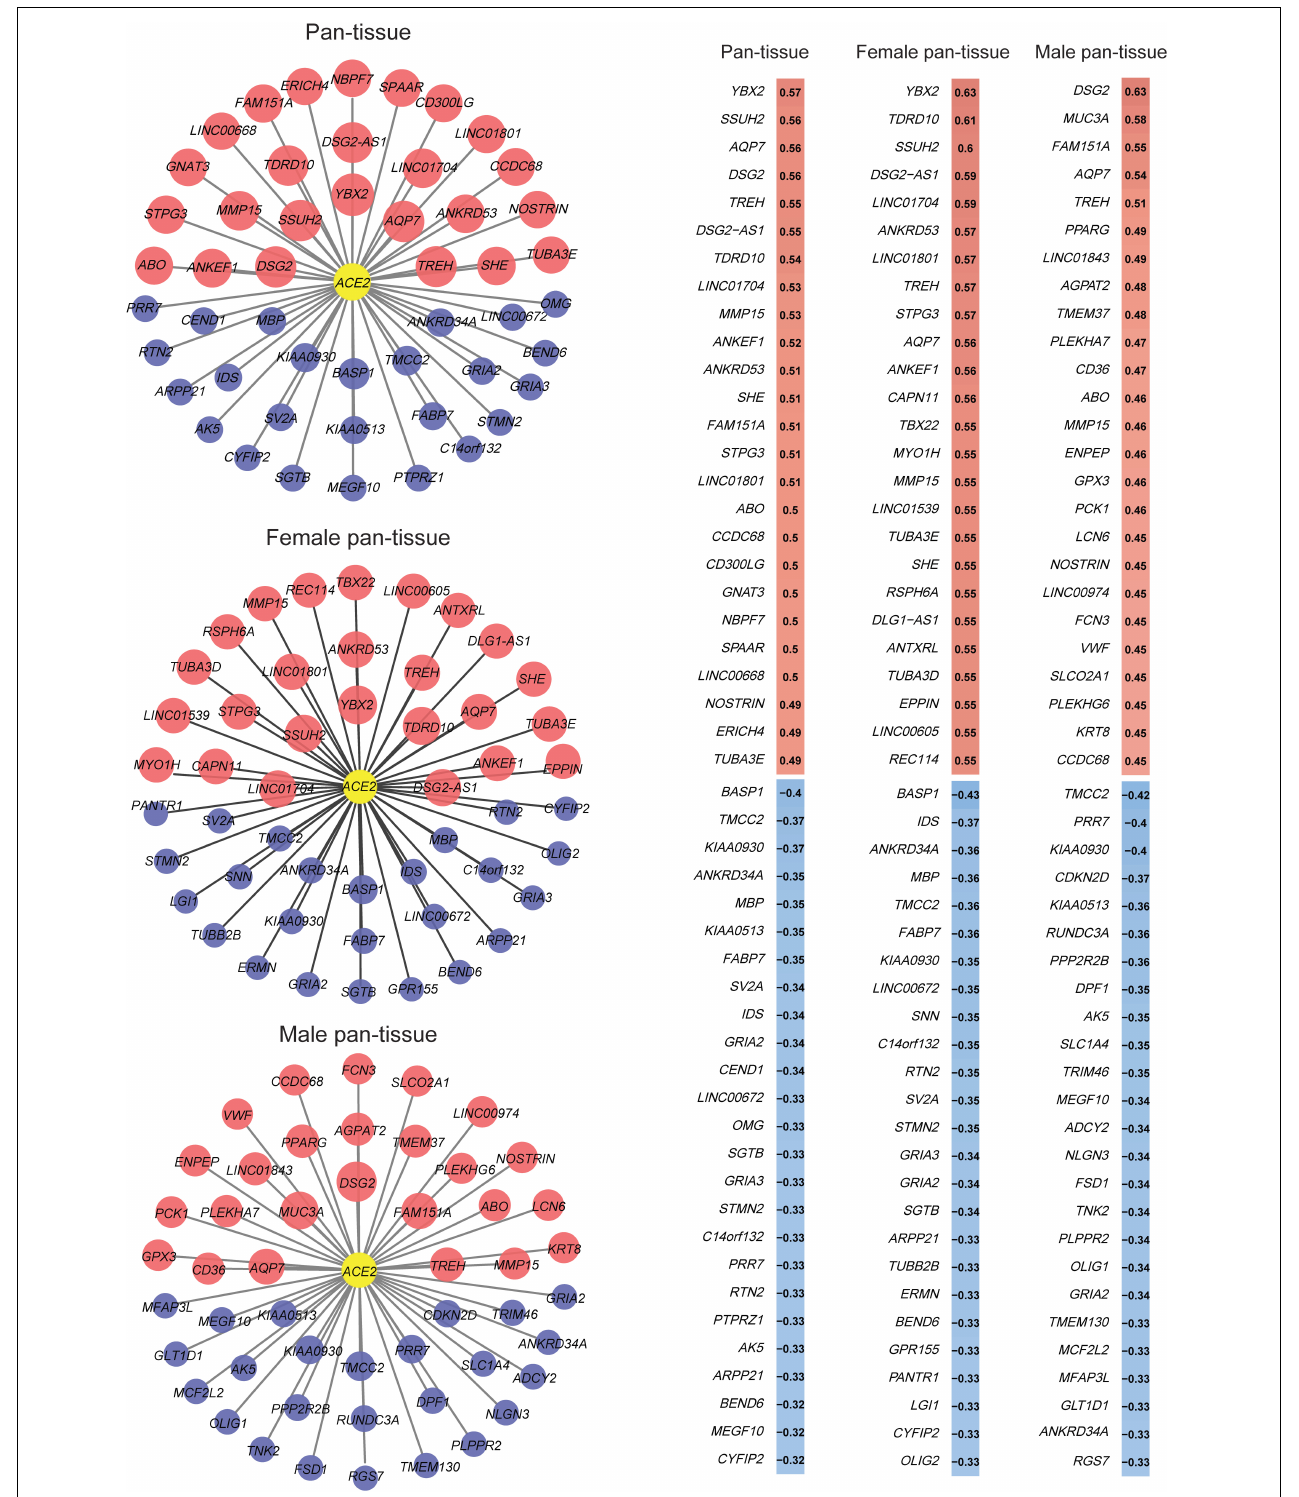
FIGURE 2 | 25 genes having the strongest positive and negative expression correlation with ACE2 in pan-tissue, female pan-tissue, and male pan-tissue. The expression correlation analysis was performed by Pearson’s correlation test, and the gene co-expression networks were generated by Cytoscape (Shannon et al., 2003). The red nodes indicated positive expression associations between the genes and ACE2 , and the blue nodes indicated negative expression associations. The size of the nodes is proportional to the correlation coefficient.